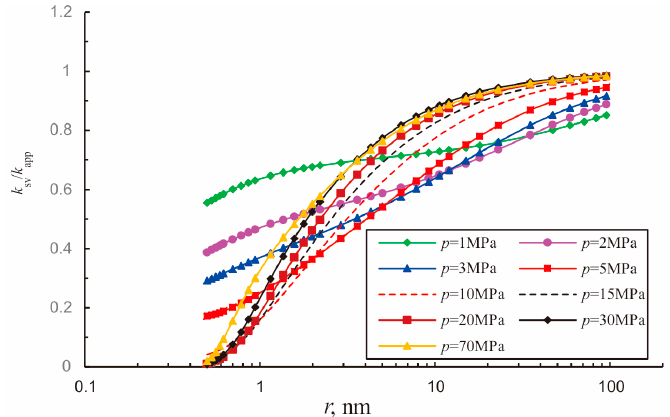
Figure 10. Contribution of slip viscous flow to total flux in different conditions.